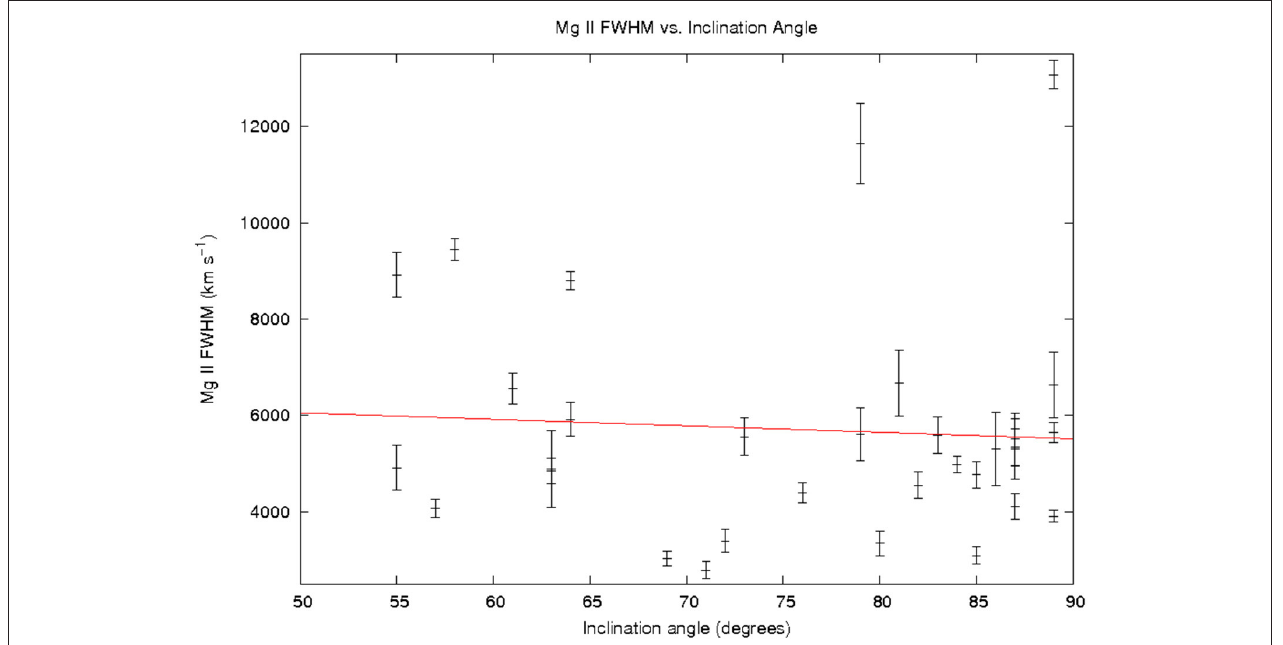
FIGURE 2 | Quasar Mg II FWHM plotted against inclination angle, with vertical bars at each point indicating FWHM 1 σ error range for each object. A best-fitting trend line (red) shows a small negative gradient, however a Pearson test indicates no